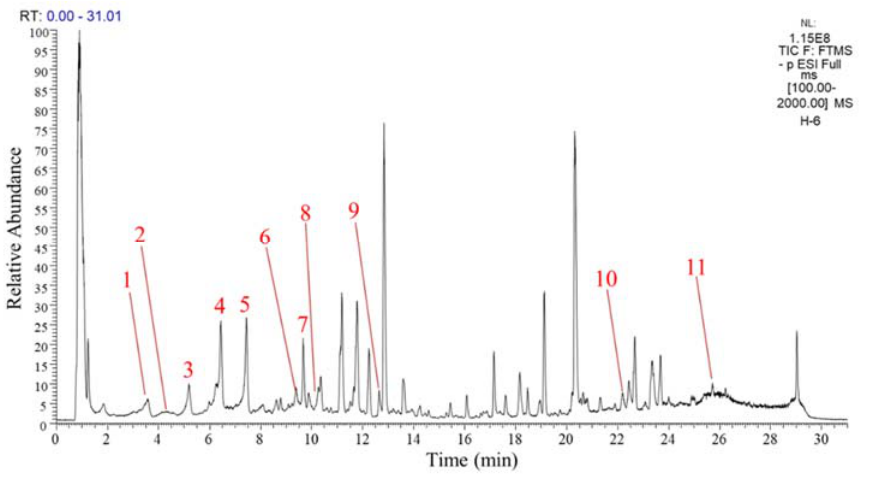
Figure 1. Total ion chromatograms (TIC) of GPH extracts. Table 2. Quantitative results by UHPLC-LTQ-OrbiTrap-MS2 for the major phenolic compounds in GPH extract.